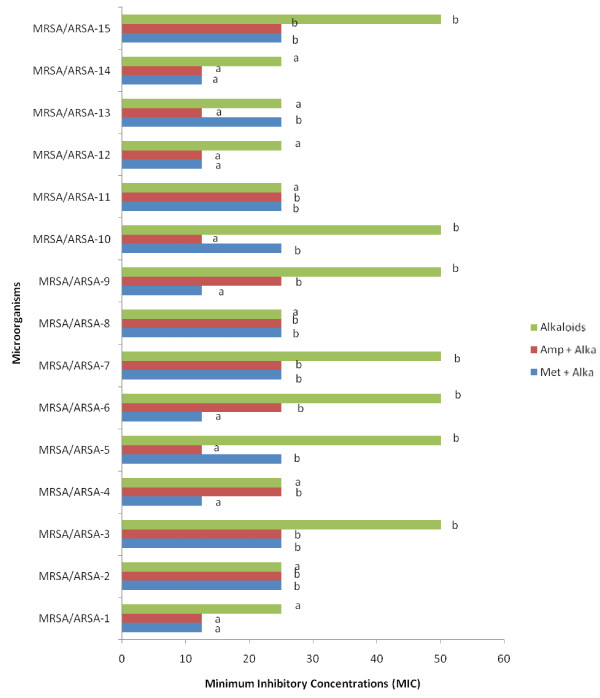
 Minimum Inhibitory Concentration (MIC) of alkaloid compounds fromCienfuegosia digitataCav. and their combination with Methicillin and with Ampicillin. The results are the means of number of the colonies ± standard deviations.